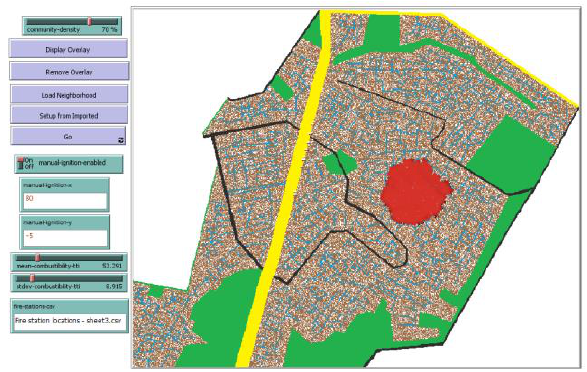
Figure 4 . Simulation ran at 70% density in BFP standard estimates, reaching Task Force Alpha alarm level.